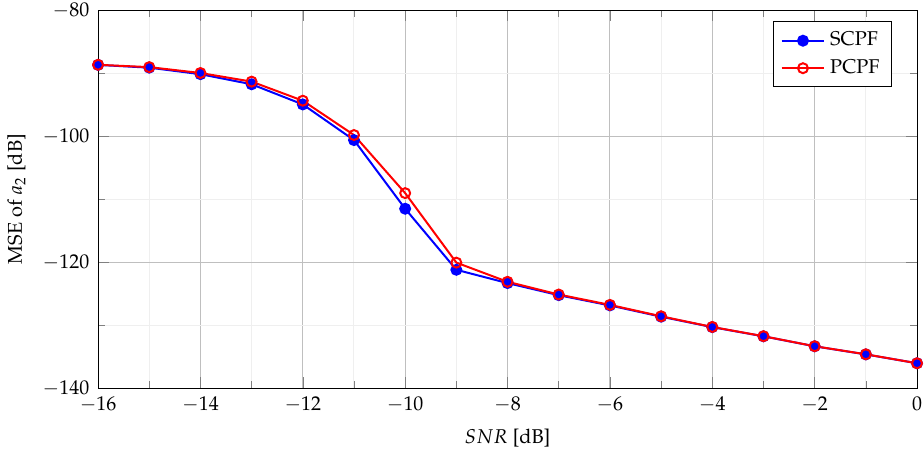
0, . . . ,4 0, . . . ,4 slices. Figure 15. MSE of the SCPF-based estimator and the PCPF-based estimator for n = { } { }